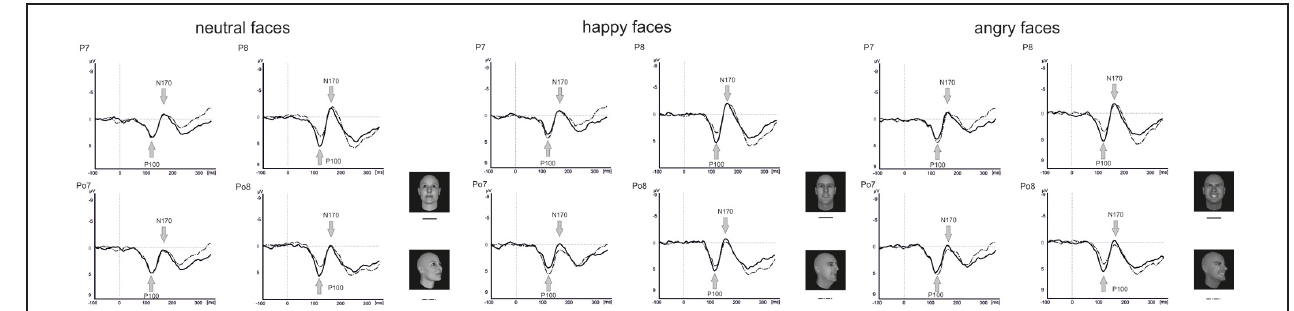
FIGURE 6 | Grand average wave forms for frontal and averted view neutral, happy, and angry